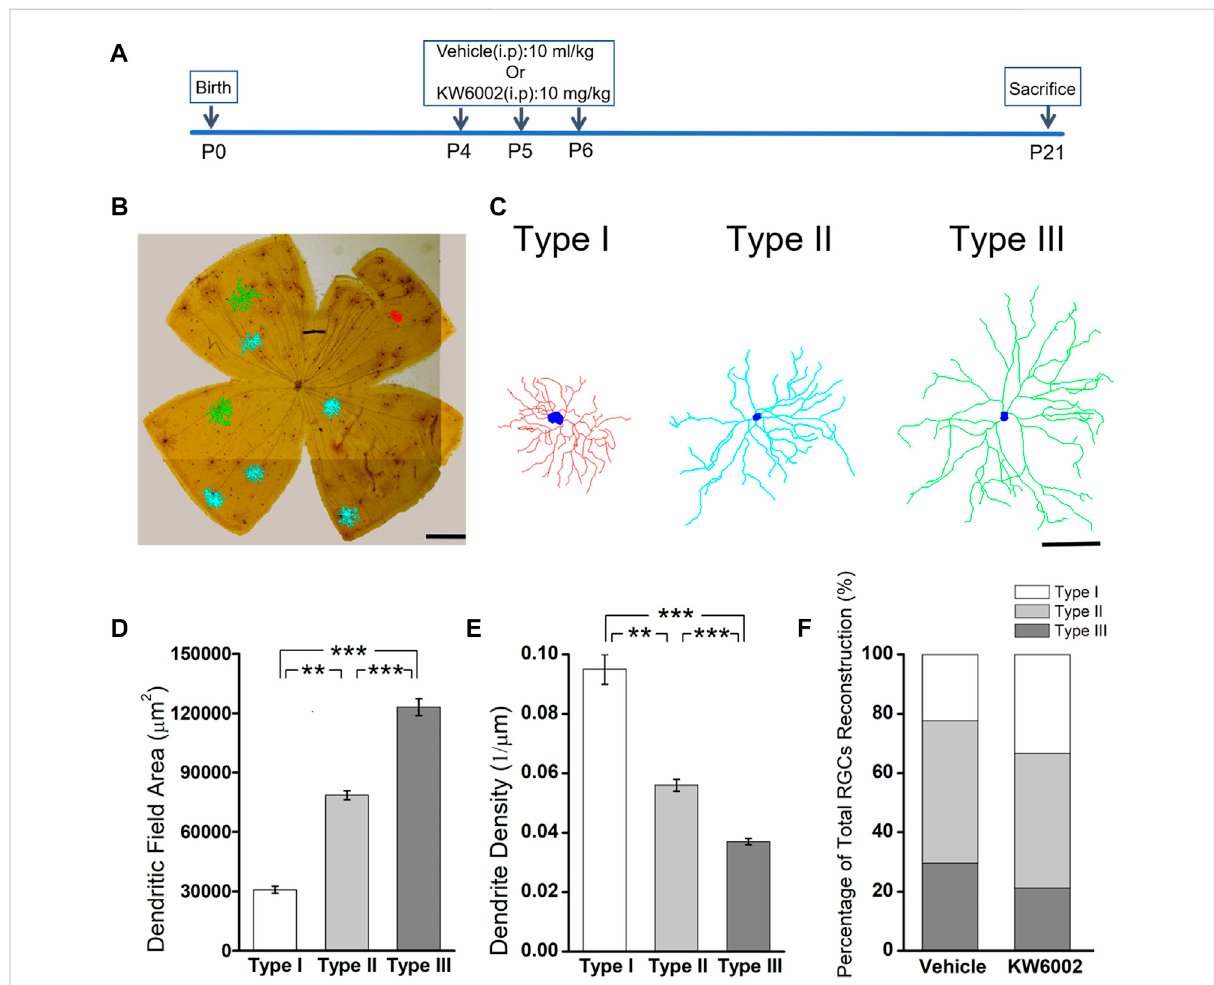
FIGURE 1 The effect of A 2A R antagonist KW6002 on the proportion of different morphological types of RGCs during the development. (A) Timeline of KW6002 (or vehicle) administration in transgenic Thy-1 YFPH mice. (B) Representative fl at-mounted whole retina showing three different morphological types of RGCs in different colors from transgenic Thy-1 YFPH mice (red, Type I; blue, Type II; green, Type III). The morphology of an individualRGCwasrevealedbyimmunohistochemistryandreconstructedbytheNeurolucidasystem.Scalebar,500 μ m. (C) Representative3D reconstructions of the three morphological types of RGCs as shown in B. Scale bar, 100 μ m. (D,E) Quantitative evaluation of dendritic fi eld area (D) anddendritedensity (E) amongdifferentmorphologicaltypesofRGCs. (F) TheproportionofdifferentmorphologicaltypesofRGCsfromthecontrol and KW6002-treated mice during the development. Values are mean ± SEM; ** p < 0.01, *** p < 0.001. 54 RGCs from six retinas (3 vehicle-treated mice) and 66 RGCs from eight retinas (4 KW6002-treated mice) were analyzed in the control and KW6002-treated group, respectively. On average, nine RGCs were analyzed in each eye in the control group, while 8.25 RGCs per eye were analyzed in KW6002-treated